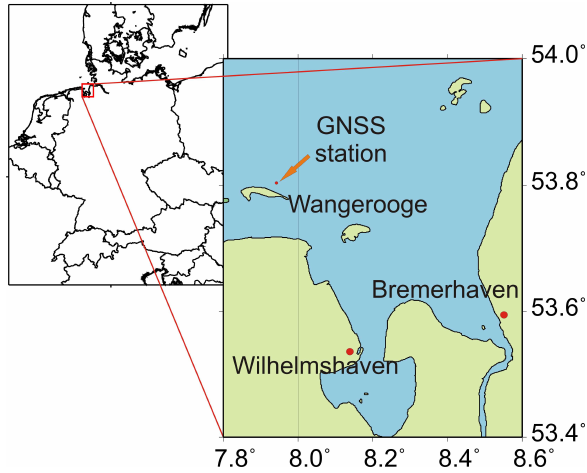
Figure 7: GNSS site in the vicinity of the island Wangerooge, North Sea, Germany.